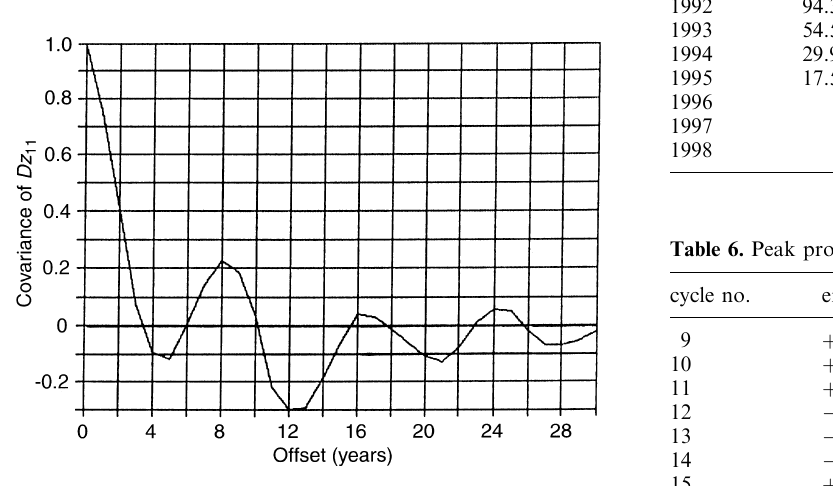
Fig. 8. Autocovariance of long-term derivative